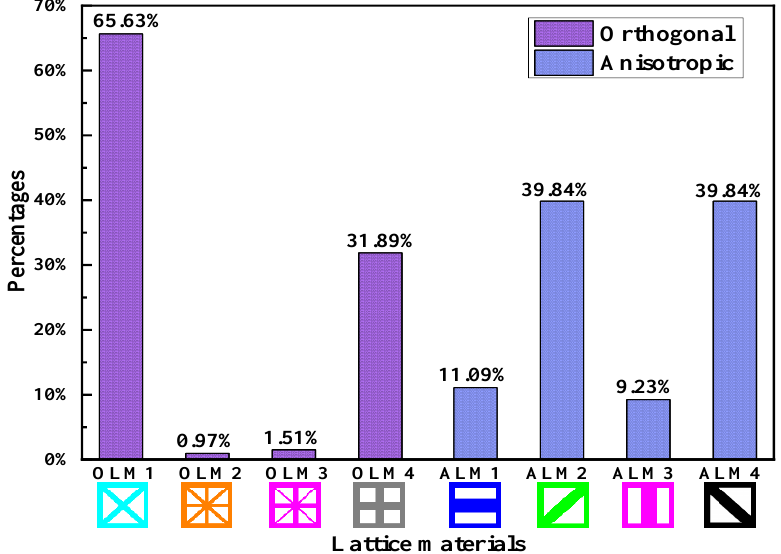
Figure 12. OLMs and ALMs percentages of HY-CGMs.